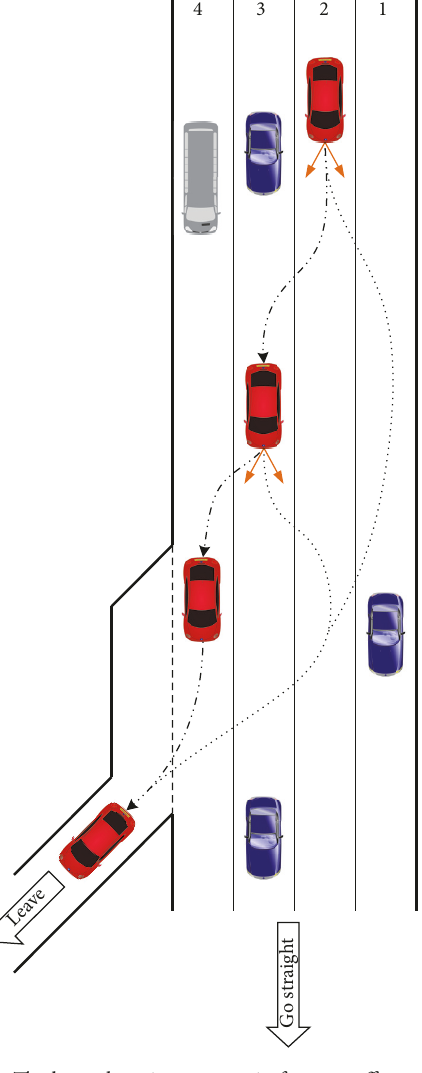
Figure 5: The lane-changing process in freeway off-ramp areas.